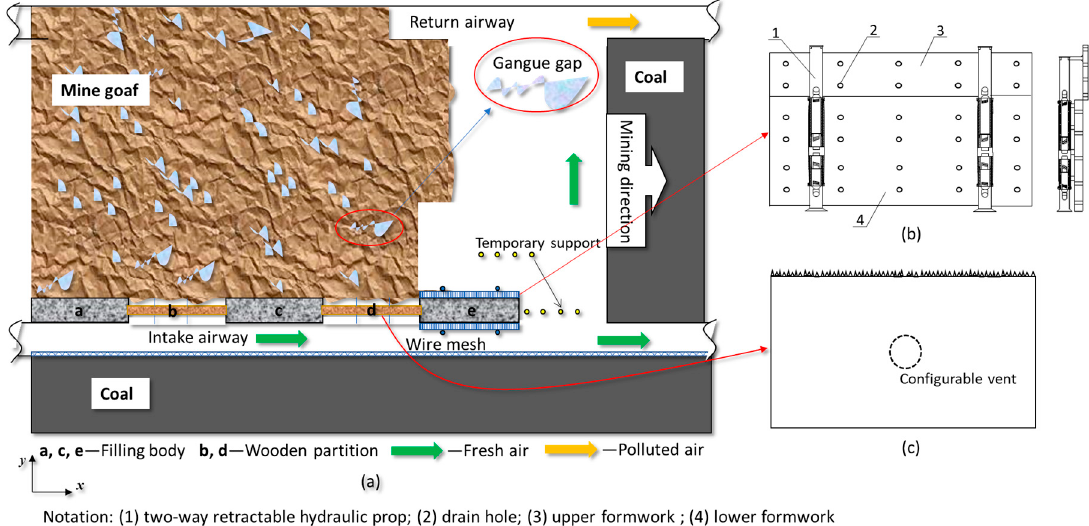
Figure 5. Schematic diagram of segmented roadside plugging-filling (SRPF): ( a ) roadway maintenance and ventilation during mining excavation in working face; ( b ) hydraulic fixed roadside filling device; and ( c ) sealing-exhaust wooden partition.